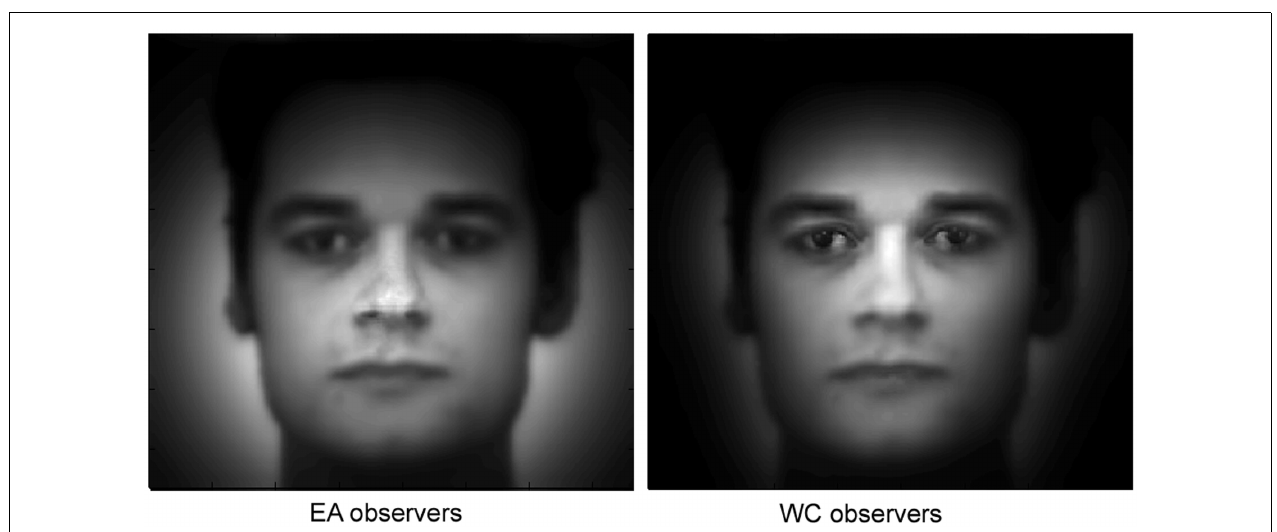
FIGURE 5 | Information span for the global (EA) and local (WC)